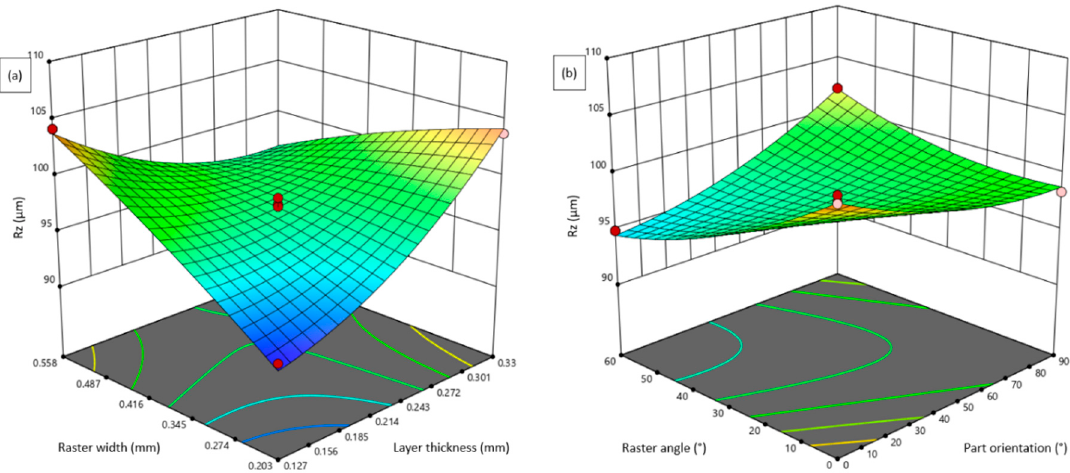
Figure 4. Influence of FDM parameters on Rz: ( a ) Layer thickness vs. Raster width; and ( b ) Part orientation vs. Raster angle.